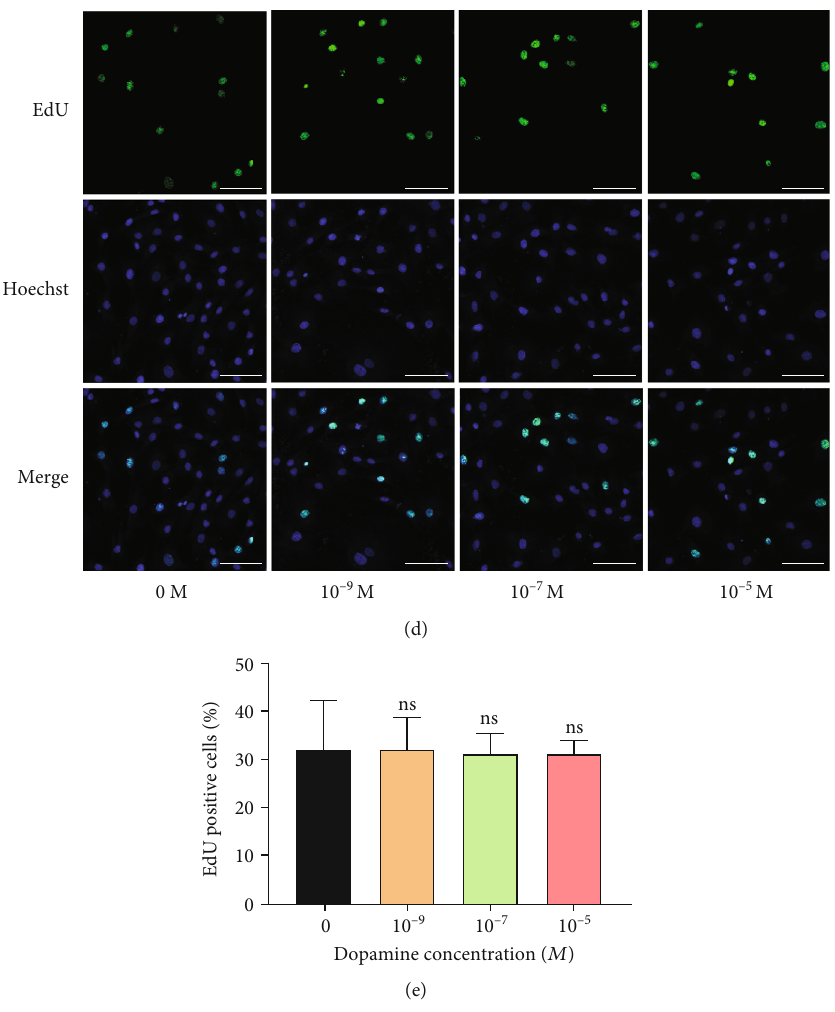
Figure 2: DA does not in fl uence the apoptosis and proliferation of rBMSCs. (a) rBMSCs were treated with di ff erent concentrations of DA for 2 days. Flow cytometric analysis of apoptosis using Annexin V-FITC/PI staining. (b) Apoptosis rate analysis. (c) E ff ect of DA on the proliferation of rBMSCs for 1, 3, 5, and 7 days evaluated by CCK-8 assay. (d) E ff ect of DA on the proliferation of rBMSCs for 1 day evaluated by EdU assay. Proliferating nuclei were labeled with EdU (green), and the nuclei of all cells were labeled with Hoechst (blue). (e) The cell proliferation ratio of the indicated groups was expressed as the ratio of EdU-positive cells to total Hoechst-positive cells. Scale bar, 100 μ m. ns: no signi fi